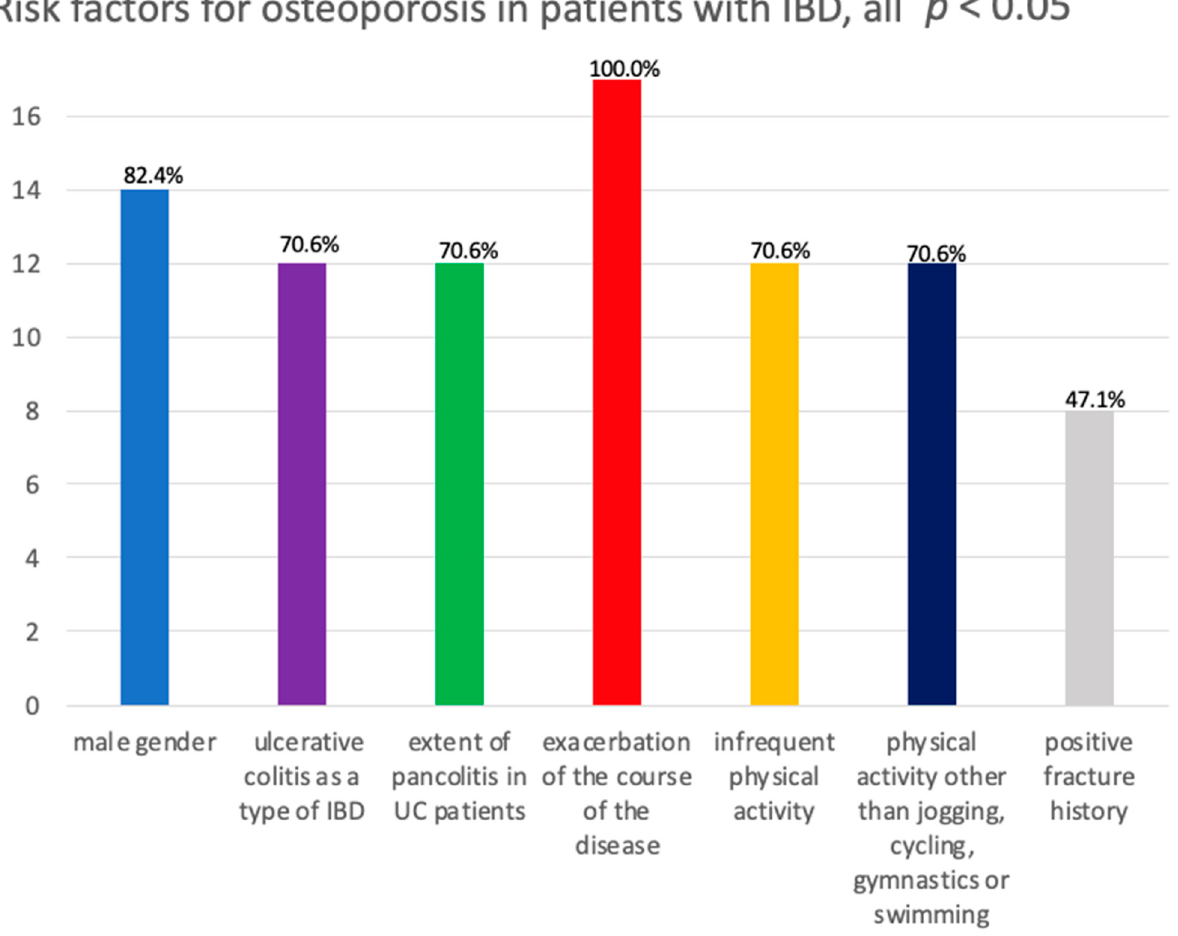
Figure 1. Risk factors for osteoporosis in patients with IBD.